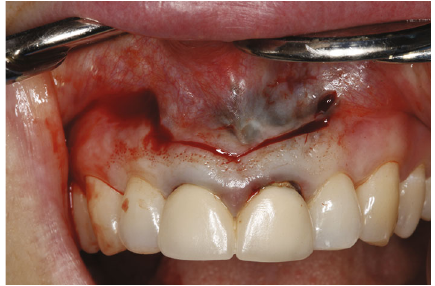
Figure 5: Submarginal incision.